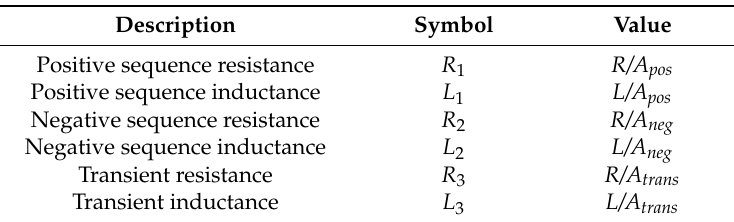
Table 2. The inductance and resistance in each